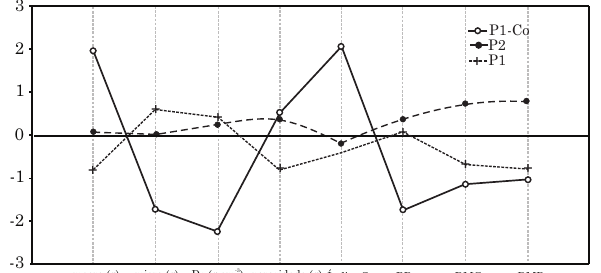
Figura 4. Centroides dos grupos das propriedades físicas do Latossolo submetidos aos tratamentos de compactação para cada grupo, segundo análise de agrupamento não hierárquico nas profundidades P1: 0-0,10 e P2: 0,10-0,20 m. C 0